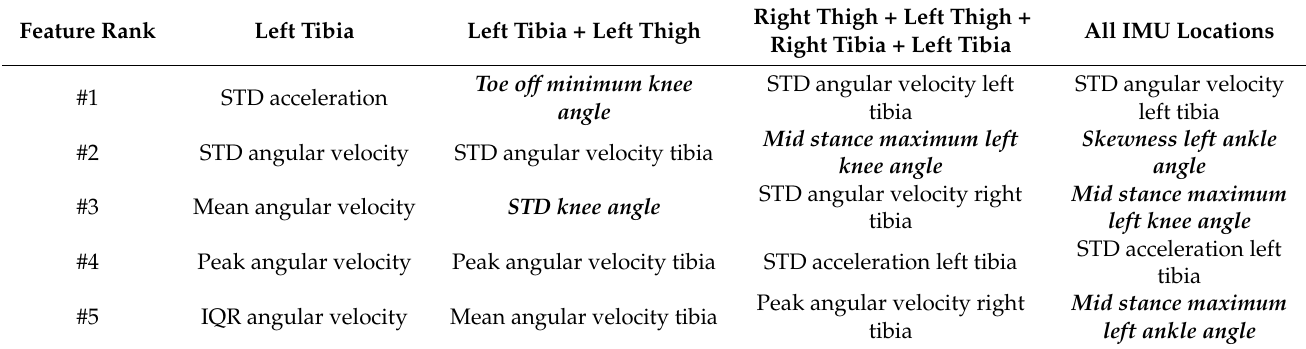
Table 6. Best features in each configuration. In bold features extracted from joint